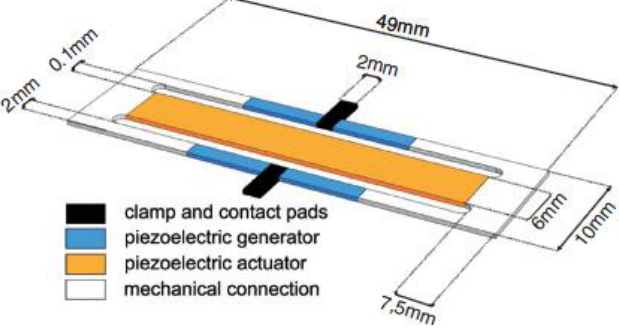
Figure 20. Self-tuning double cantilevered harvester [88] ( © IOP Publishing. Reproduced by permission of IOP